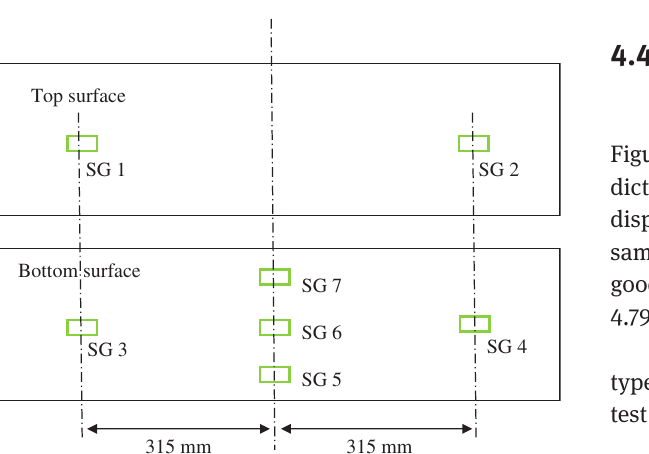
Figure 14: Test rig setup of the composite-based leaf springs.